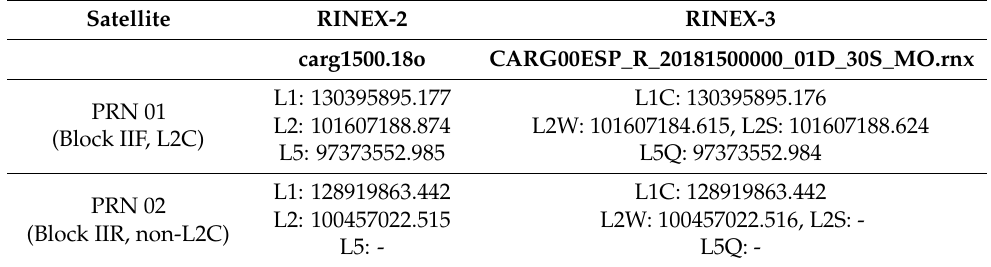
Table 1. Two sample data sets of corresponding RINEX-2 and RINEX-3 phase observations [cy] used to